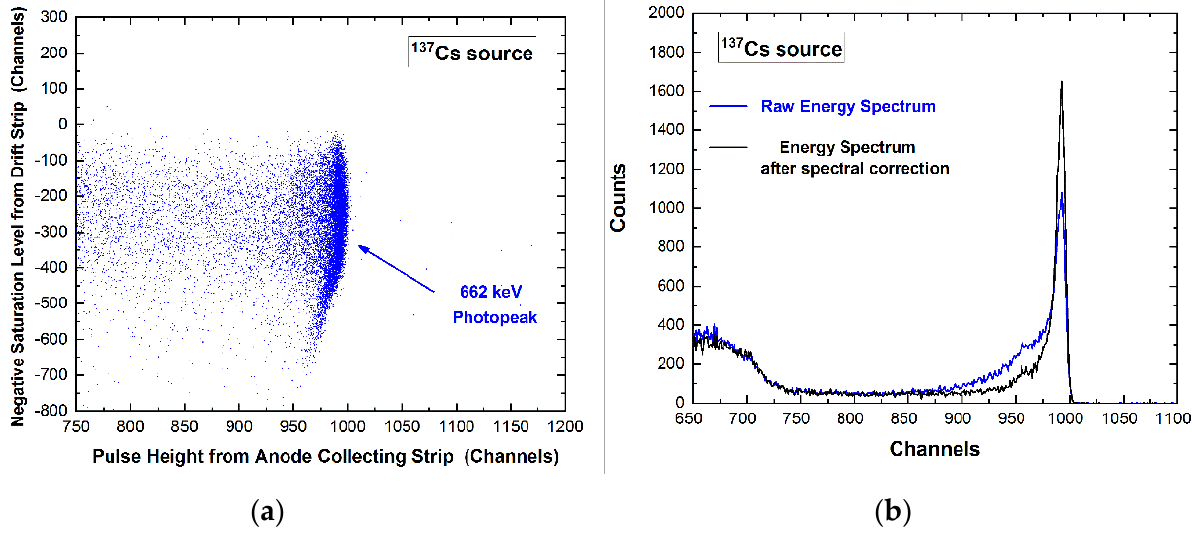
Figure 5. ( a ) Two-dimensional (2D) scatter plot of the negative saturation level of the pulses from a drift strip versus the height of pulses from an anode collecting strip. The curvature highlights the presence of pulses with incomplete charge collection related to high values of the negative saturation level. ( b ) Measured 137 Cs energy spectra after the spectral correction (black line) [36]. The events in the tailing of the photopeak, i.e., characterized by incomplete charge collection, are well detected and corrected.